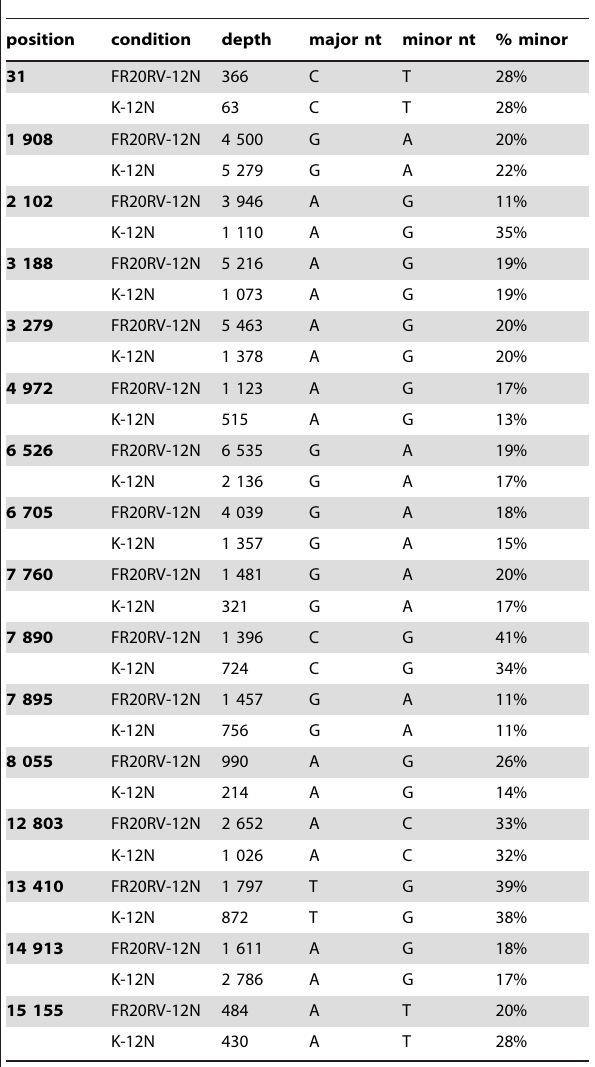
Table 2. Variant calling in the 12-mer datasets at genome positions with depth larger than 100 6 (except for position 31 in the K-12N condition) and minor nucleotide percentage of at least 10%.